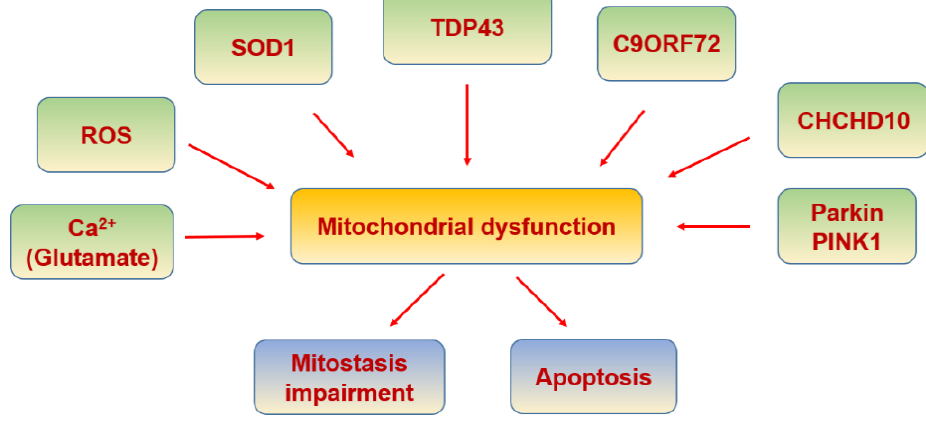
Figure 10. Amyotrophic lateral sclerosis and mitochondria.